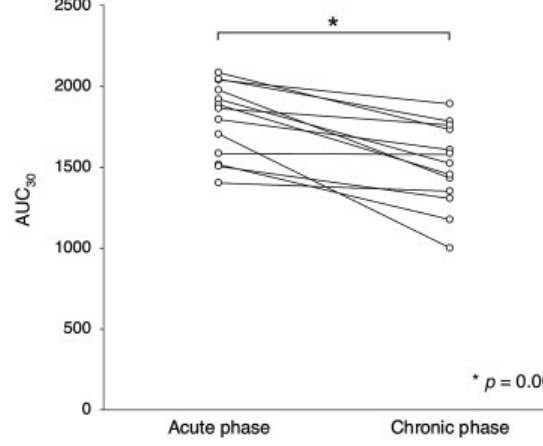
Fig.3 Serial changes of blood thrombogenicity from the acute to chronic phase in acute MI. AUC 30 levels decreased signi fi cantly from acute to chronic phase in patients with acute MI (1,859 [1,550 – 2,008] to 1,521 [1,328 – 1,745], p ¼ 0.001). MI, myocardial